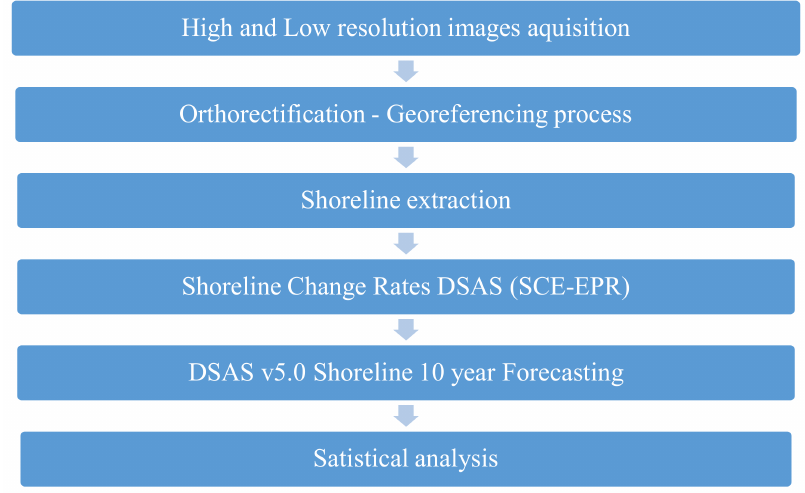
Figure 2. Chart diagram of the study